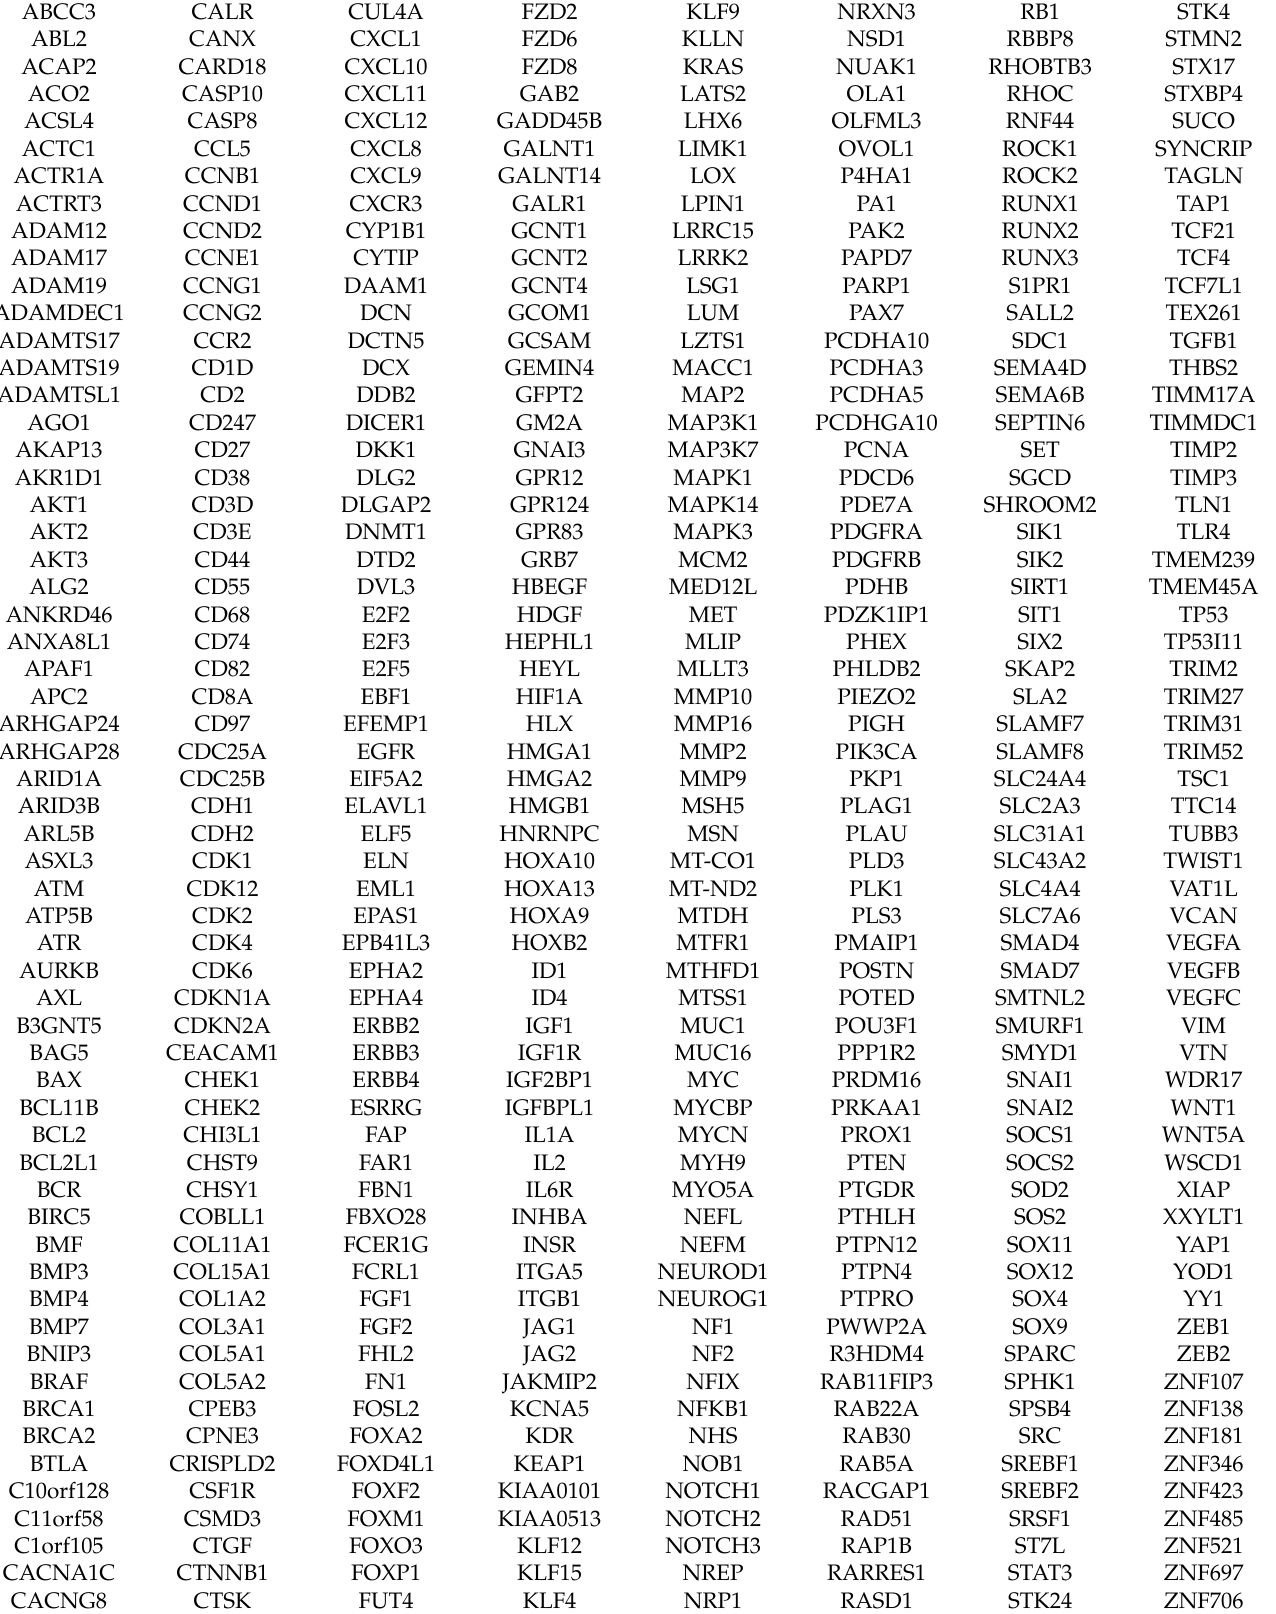
Table 3. List of 472 proteins related to ovarian cancer with the protein–protein interaction-networks functional enrichment analysis tool String (https://string-db.org (accessed on 7 November